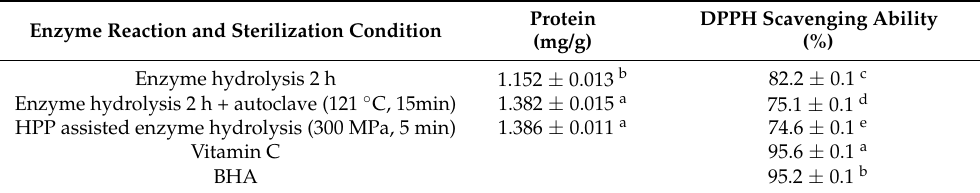
Table 5. Effect of HPP assisted enzyme hydrolysis on total protein content and antioxidant activity of wild bitter gourd extract. Enzyme Reaction and Sterilization